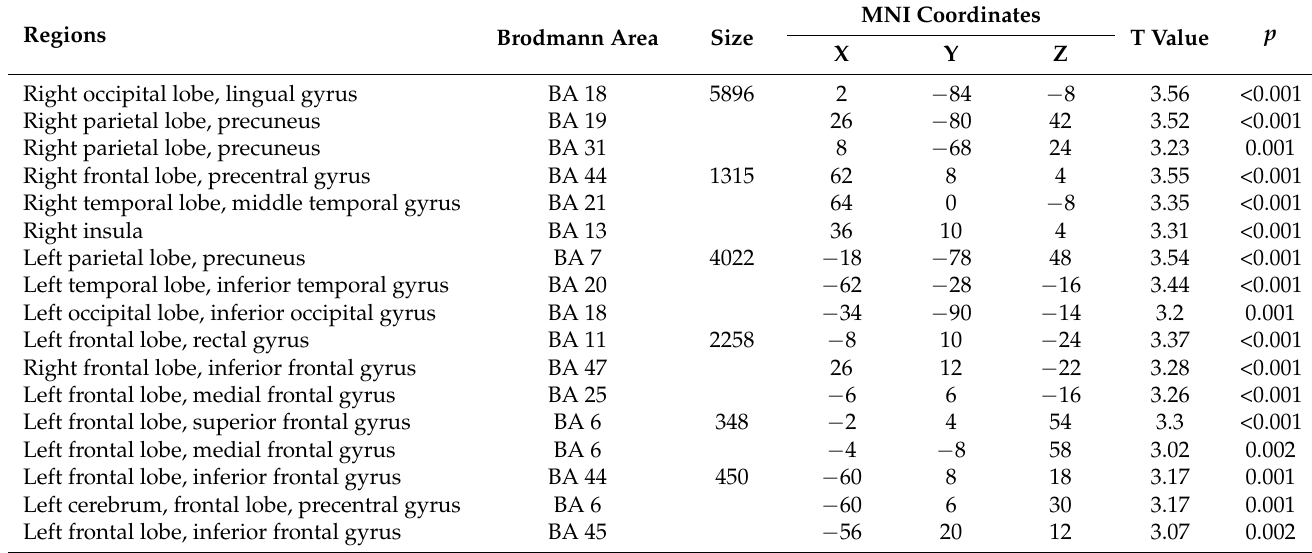
Table 3. Regions of significantly increased cerebral A β burden in high VAT metabolism group compared to low VAT metabolism group in SPM analysis ( p < 0.005 uncorrected, k =